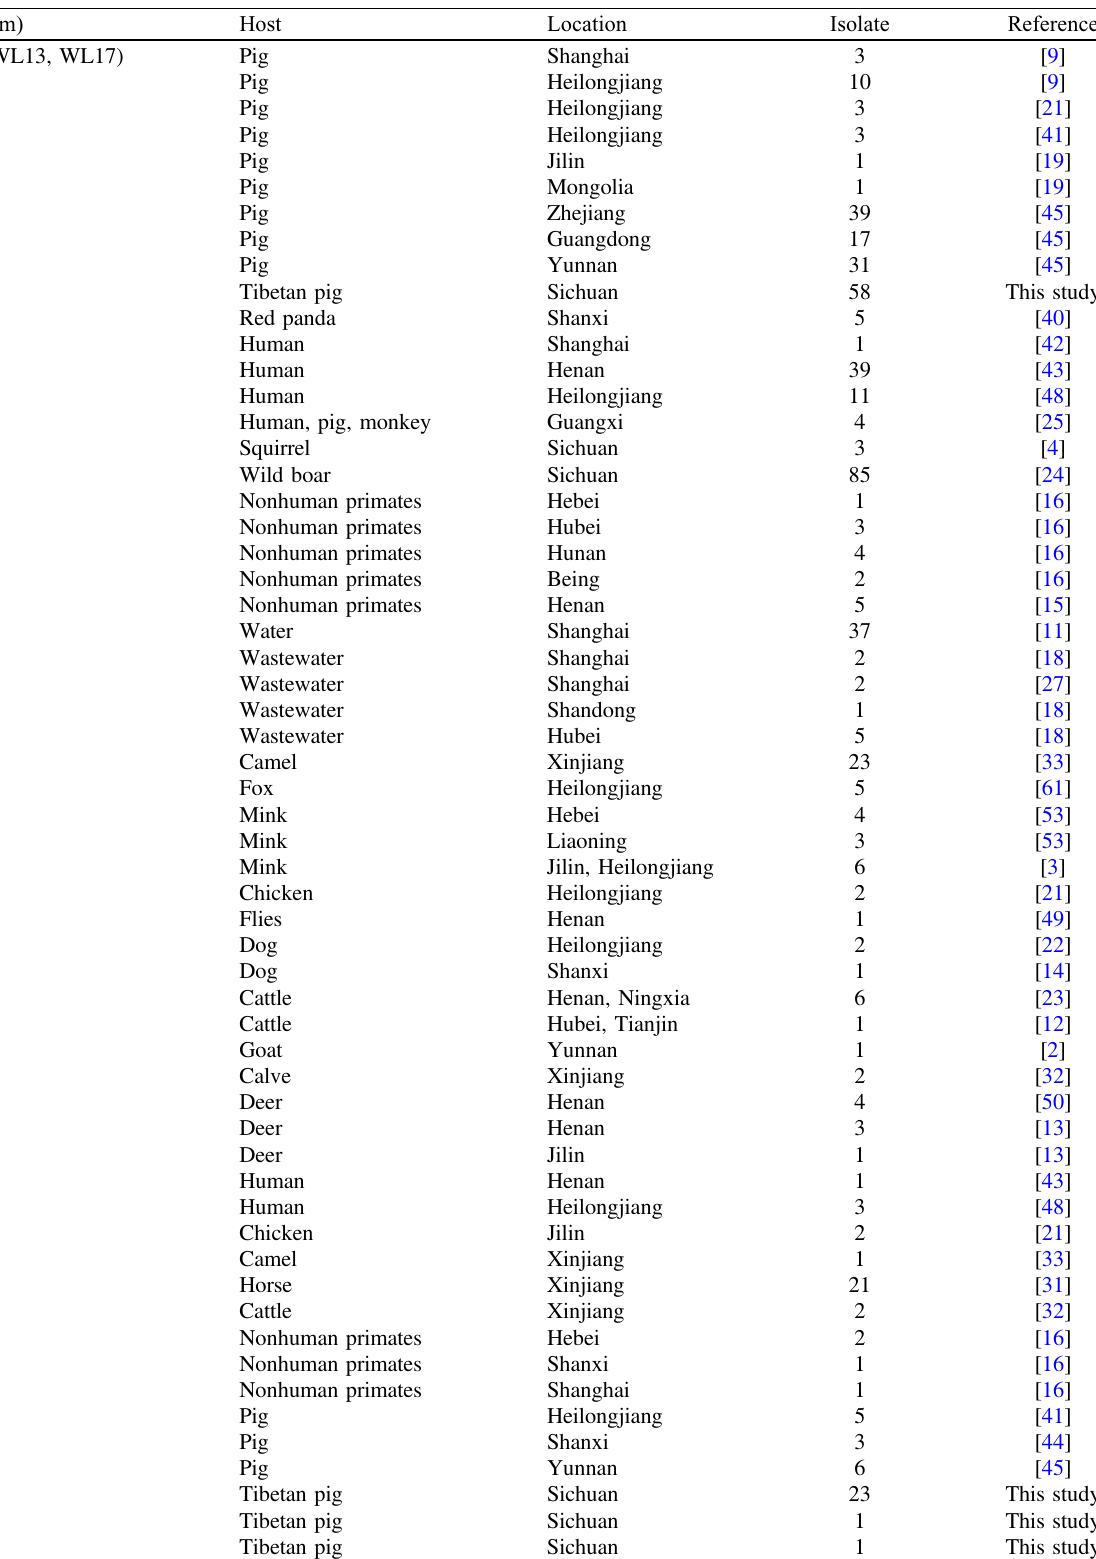
Table 4. Host ranges and geographical distribution of Enterocytozoon bieneusi genotypes in this study in China. Genotype